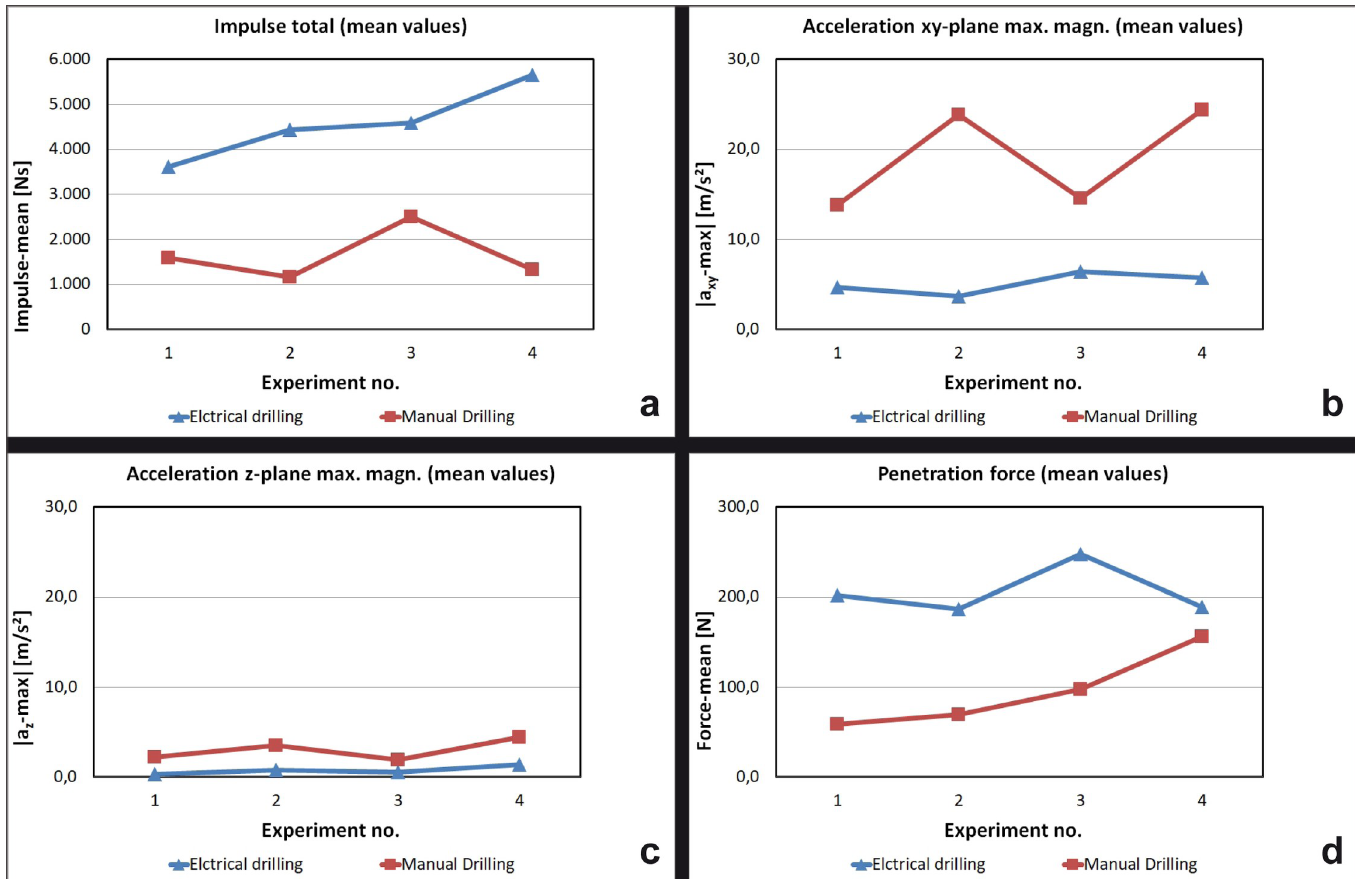
Fig 4. Drilling paramaters (II). (A) Impulse (B) Acceleration xy-plane (C) Acceleration z-plane (D) Penetration force.